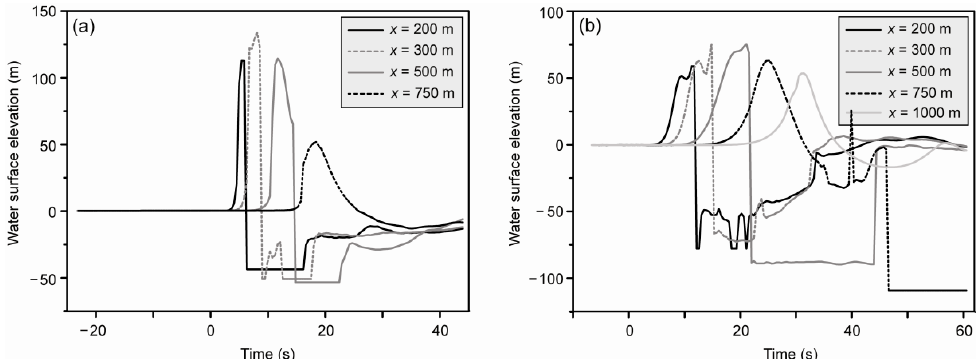
Figure 7. Time history of the water surface elevation measured along the slide axes; ( a ) scenario 1 resulting in a maximum wave amplitude of 133.0 m and ( b ) scenario 2 resulting in a maximum wave amplitude of 75.4 m.